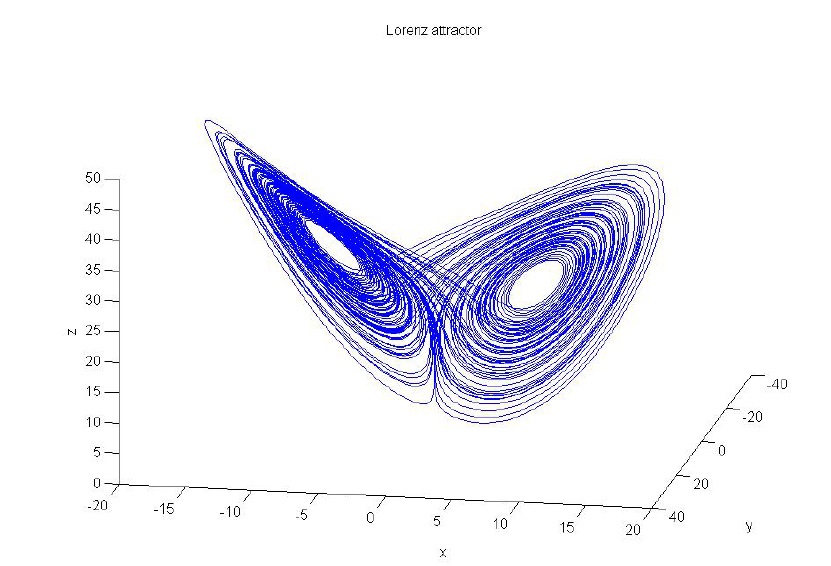
Figure 1. Lorenz